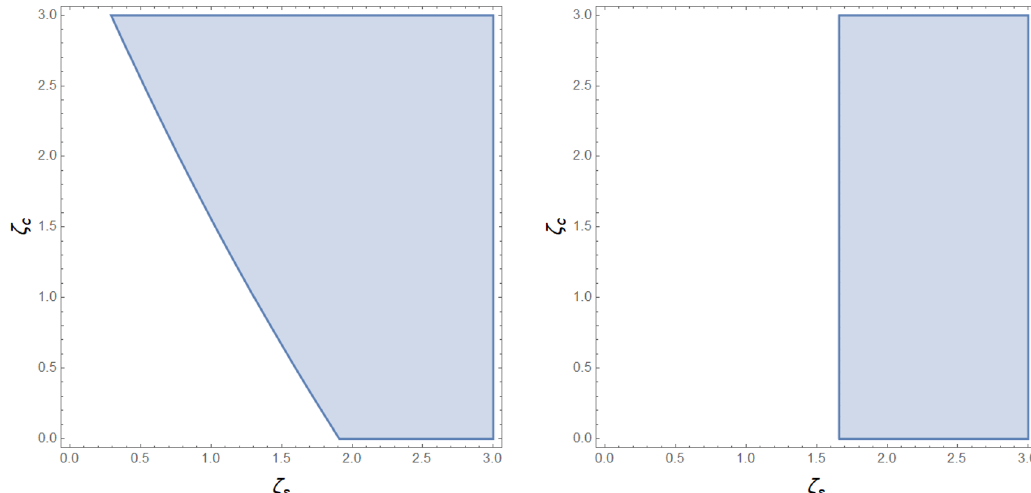
Figure 5 . Parameter space for ζ s and ζ c satisfying m 2 > H . We took ( λ, ξ, α ) = (0 . 5 , 10 4 , 10 10 ) for R 2 -like inflation on left and ( λ, ξ, α ) = (4 × 10 − 5 , 1 , 10 2 ) on right for Higgs-like inflation. In both figures, we fixed ρ = 0 . 1 and φ = 10